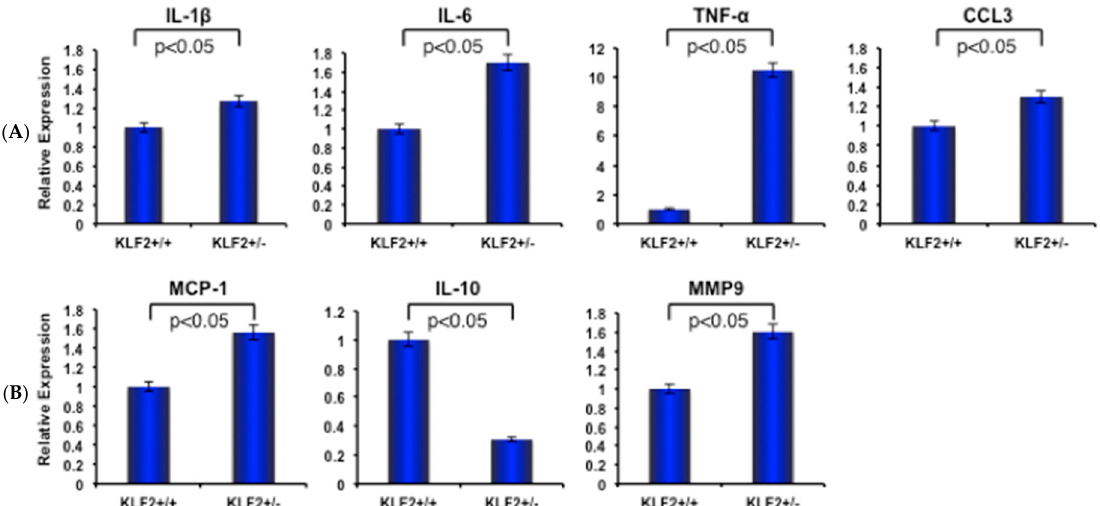
Figure 3. Inflammatory molecules are elevated in bone marrow cells of KLF2 +/ − mice after induced arthritis. ( A ) Quantitative real-time PCR was performed to determine relative expression of various arthritis-related factors in bone marrow from KLF2 +/ − and KLF2 +/+ mice after development of K / BxN serum-induced arthritis. ( B ) The levels of matrix metalloproteinases (MMPs) were assessed in bone marrow from KLF2 +/ − and KLF2 +/+ mice after development of K / BxN serum-induced arthritis; mice without arthritis were used as controls.